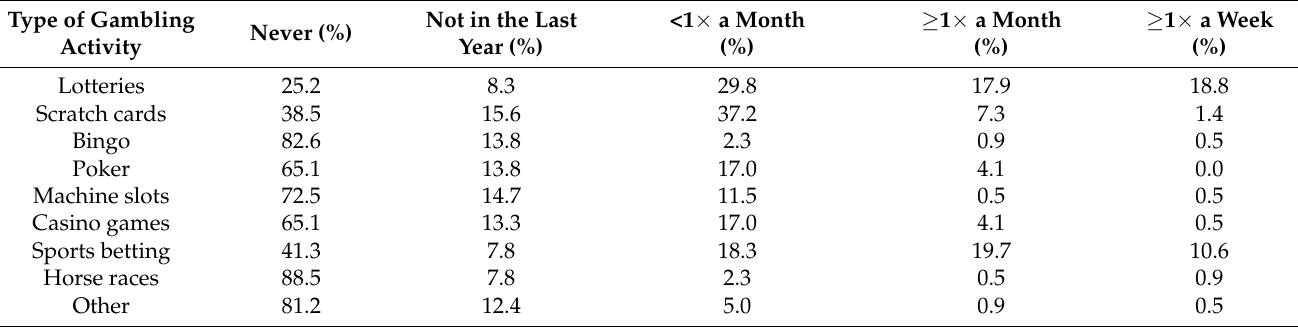
Table 2. Last year gamblers involvement in different gambling practices ( n =